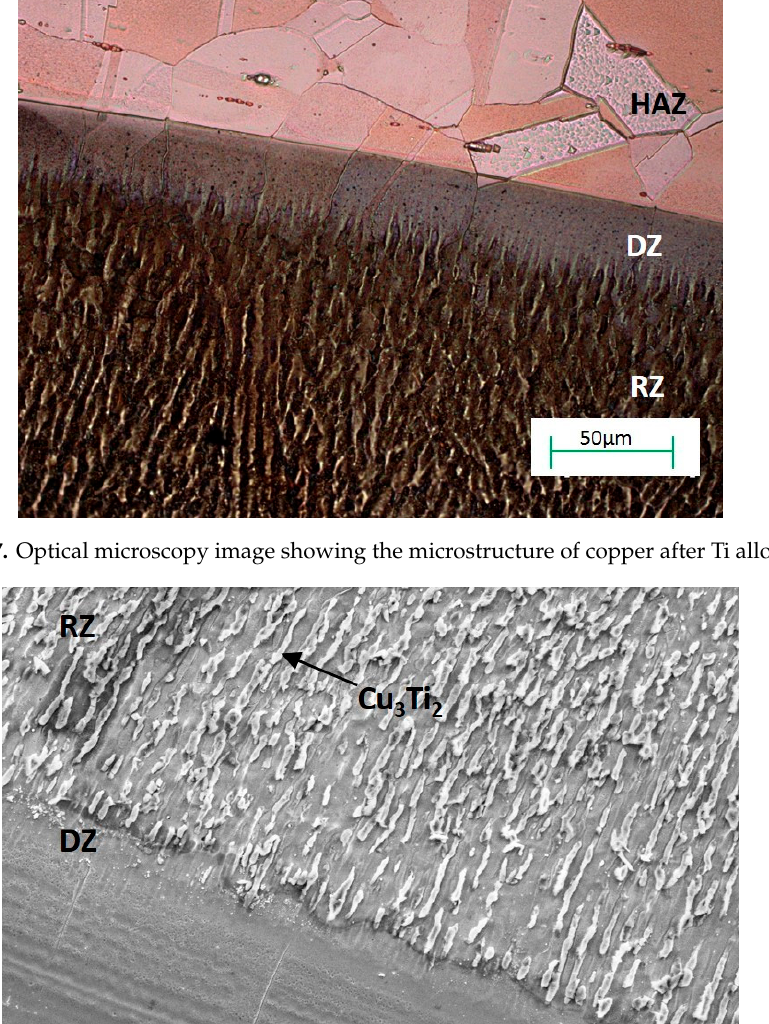
Table 2. Results of the EDS spectrum analysis for the areas from Figure 6 (wt.%).